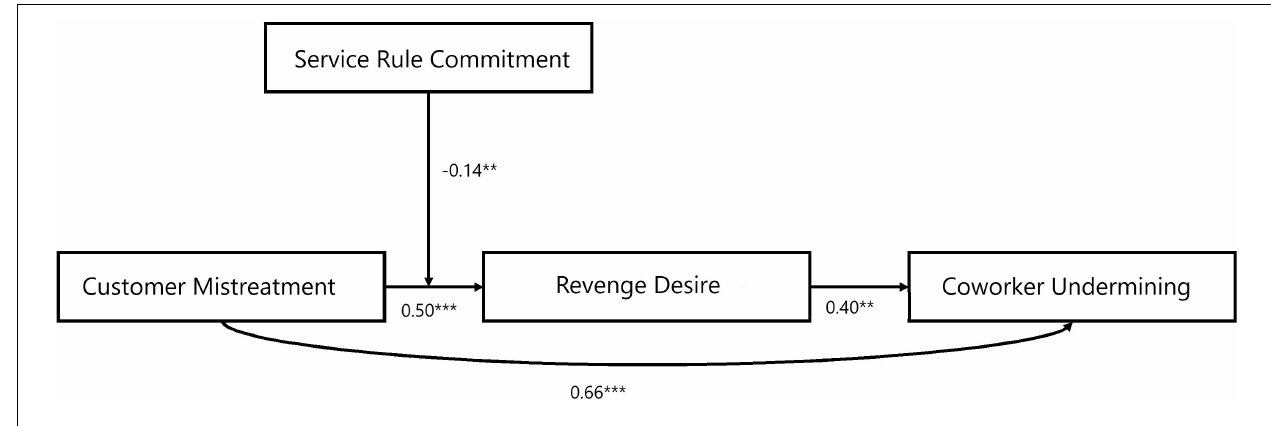
FIGURE 1 | Results of moderated-mediation model. ** p < 0.01; *** p <